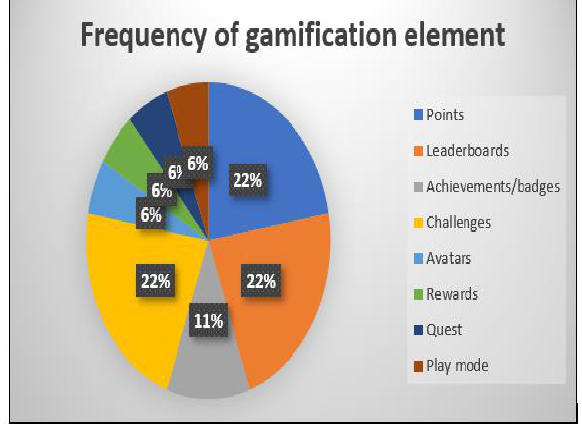
Figure 2 . Frequency of gamification element